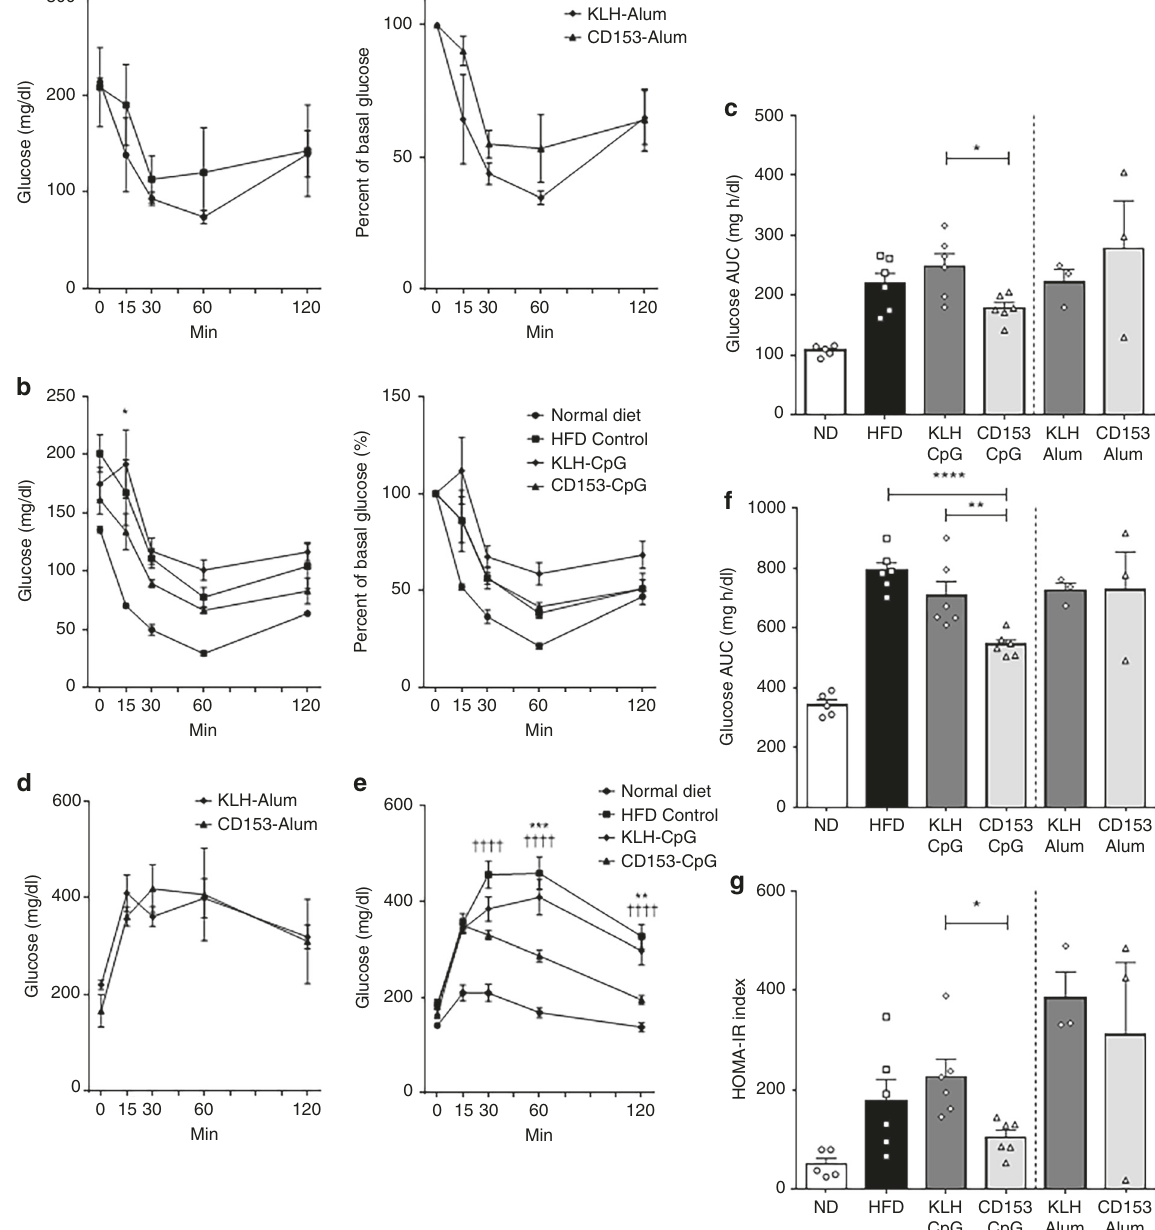
Fig. 3 Glucose tolerance and insulin sensitivity in HFD-loaded mice immunized with CD153 vaccine. a – c Blood glucose concentrations and percent basal glucose in mice immunized with the Alum-conjugated vaccine (CD153-Alum or KLH-Alum) ( a ; n = 3 in each group) or the CpG-conjugated vaccine (CD153-CpG or KLH-CpG) ( b ; n = 6 in each group) as determined by the intraperitoneal insulin tolerance test (ipITT). Mice in both the ND (normal diet, n = 5) and HFD (high-fat diet, n = 6) control groups were treated in a manner similar to the vaccinated group. Asterisk indicates the CD153-CpG group vs. the KLH-CpG group. c Area under the curve (AUC) of blood glucose levels as determined by the ITT. The AUC was estimated using the trapezoidal rule. d – f Blood glucose concentrations in mice immunized with the Alum-conjugated vaccine ( d ; n = 3 in each group) or the CpG-conjugated vaccine ( e ; n = 6 in each group) as determined by the oral glucose tolerance test (OGTT). Mice in both the ND (normal diet, n = 5) and HFD (high-fat diet, n = 6) control groups were treated in a manner similar to the vaccinated group. Asterisk indicates the CD153-CpG group vs. the KLH-CpG group. Dagger indicates the CD153-CpG group vs. the HFD control group. f AUC of blood glucose levels as determined by the OGTT. The AUC was estimated using the trapezoidal rule. g HOMA-IR index after 6 h of fasting. Alum-conjugated vaccine group, n = 3 in each group; CpG-conjugated vaccine group, n = 6 in each group; ND control group, n = 5; HFD control group, n = 6. All the data are expressed as the mean ± SEM. Statistical evaluation was performed by two sided; unpaired two-tailed t-test, KLH-Alum vs. CD153-Alum ( c , f , g ); Bonferroni correction, HFD vs. KLH-CpG vs. CD153-CpG (C, F and G); Tukey ’ s multiple comparison test ( a , b , d , e ); * p < 0.05; ** p < 0.01; *** p < 0.001; **** p < 0.0001; †††† p <